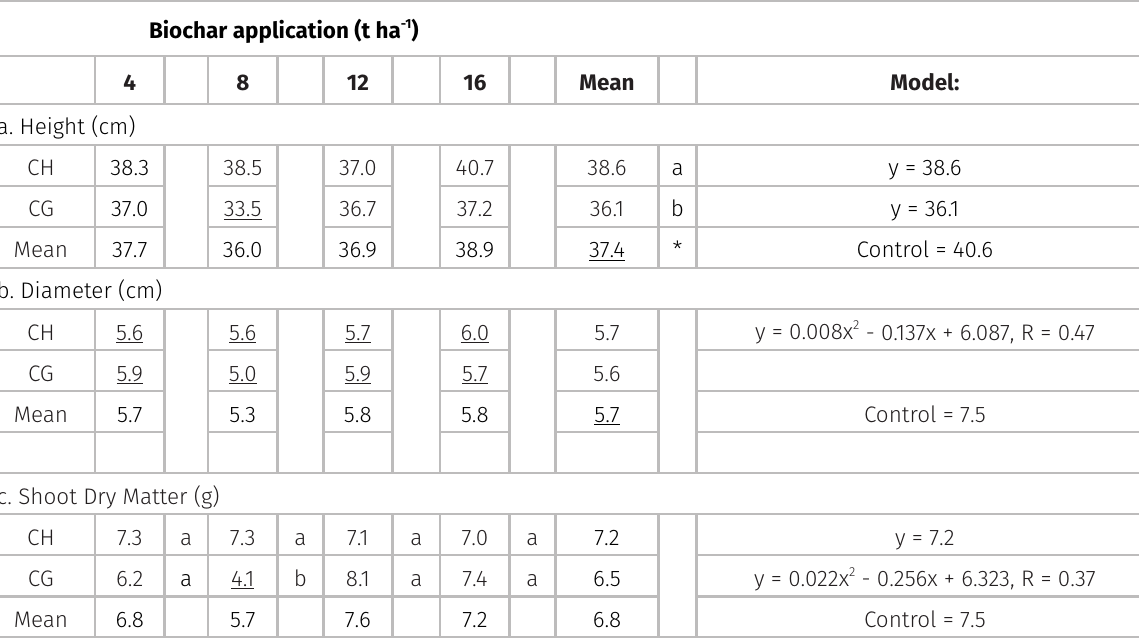
Table II. Initial growth of bean plants cultivated in sandy Entisol treated with biochar produced from the coffee ground (CG) and coffee husk (CH) residues applied to sandy Entisol in Northeastern Brazil.